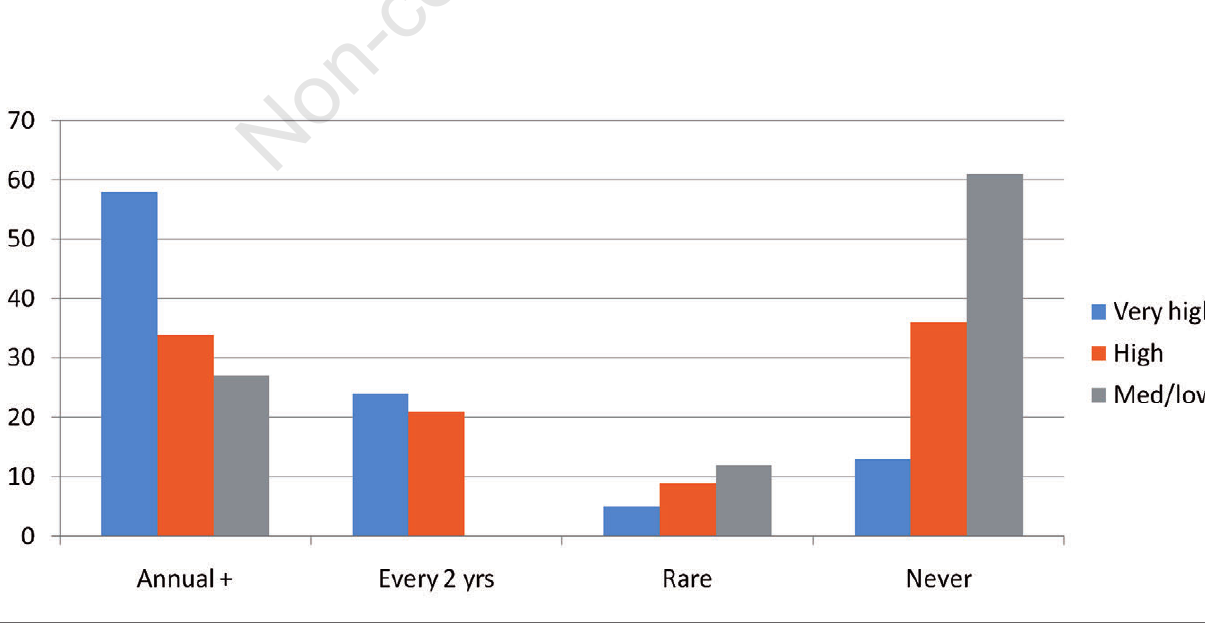
Figure 4. Frequency of MRI testing for cardiac iron and country HDI